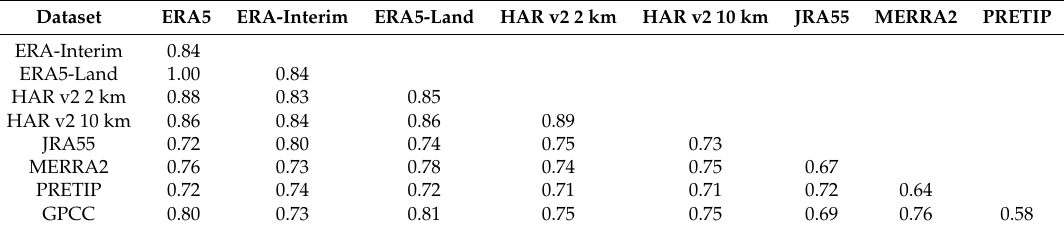
Table A1. Correlation coefficient R for all datasets in mm/10days . All correlations are statistically significant at the 99% confidence interval.